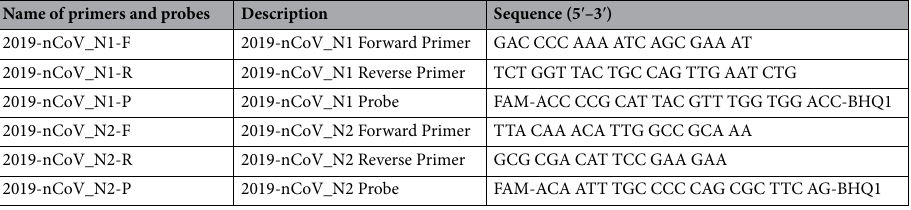
Table 1. Primers and probes